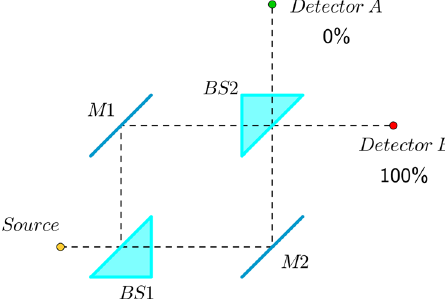
FIG. 8. Results for the Mach-Zehnder experiment with an intermediate detector C, which can reveal the passage of the photon without destroying or perturbing